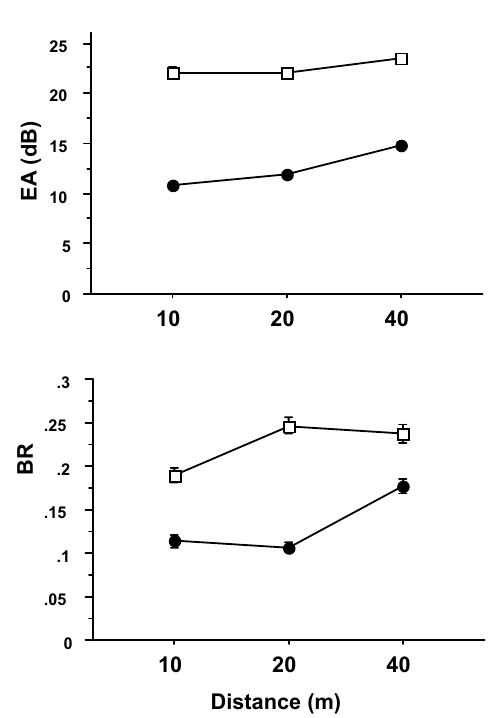
Fig. 1 – Signal degradation (mean ± SE) of Pied Flycatcher song elements at three different distances inside (open squares) and outside (filled circles) a nest hole. EA: excess attenuation, BR: blur